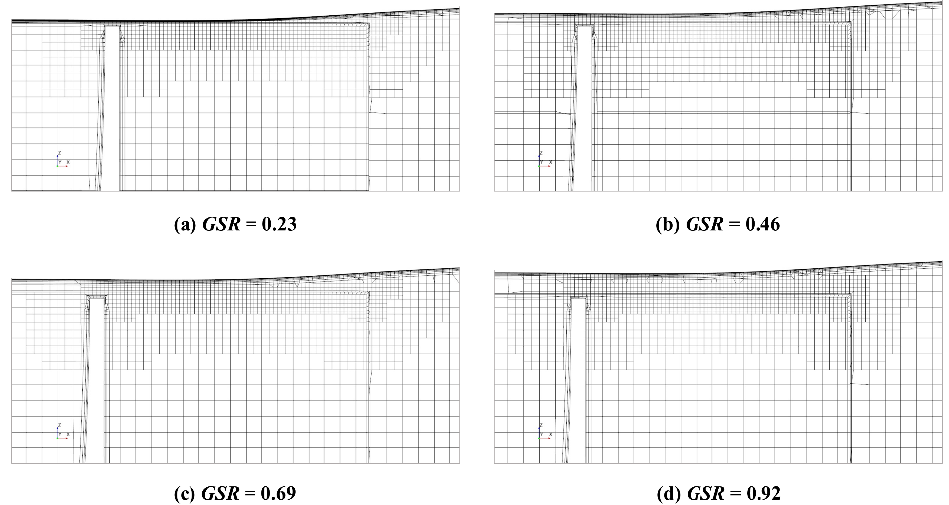
Figure 10. Side views of the meshes of propellers with different gap-to-span ratios (GSRs).